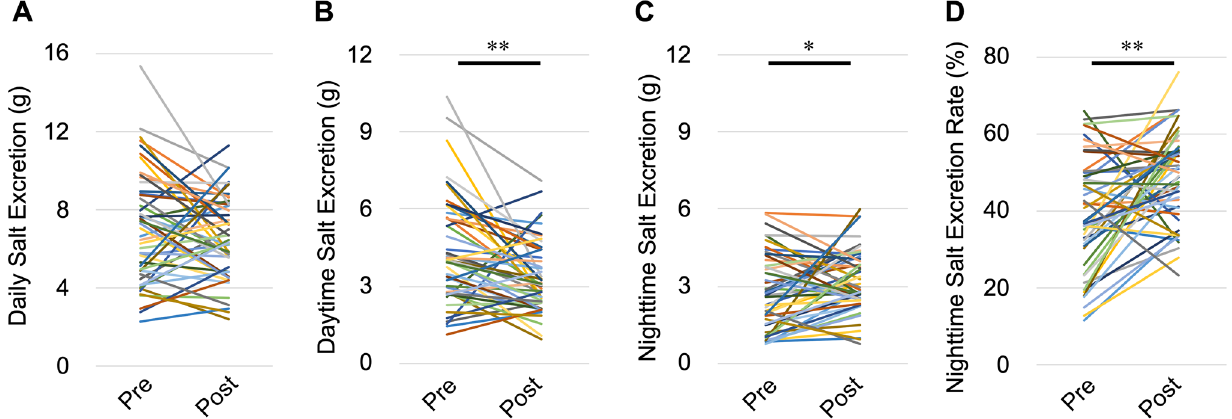
Figure 3. Changes in salt excretion caused by nephrectomy. ( A ) Daily salt excretion, ( B ) daytime salt excretion, ( C ) nighttime salt excretion, and ( D ) the nighttime salt excretion rate. Pre preoperative, Post postoperative. * P < 0.05, ** P < 0.01, by the paired t -test.